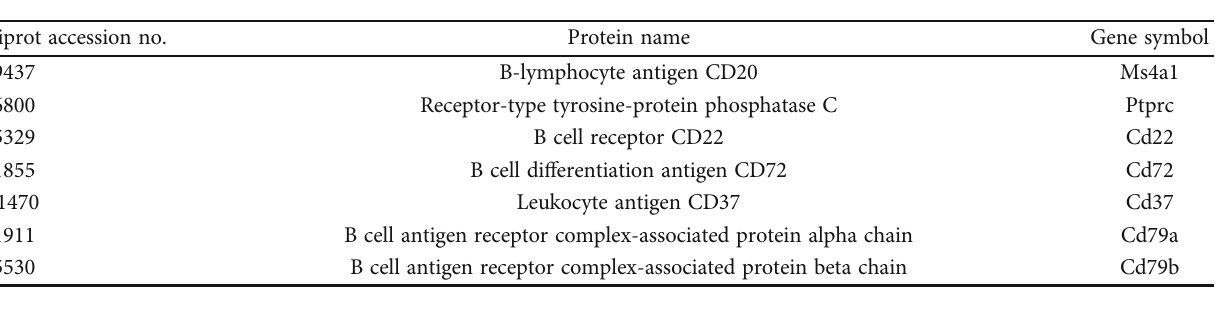
Table 1: B cell markers (a) and immunity-related molecules (b) identi fi ed in the proteomic analysis.